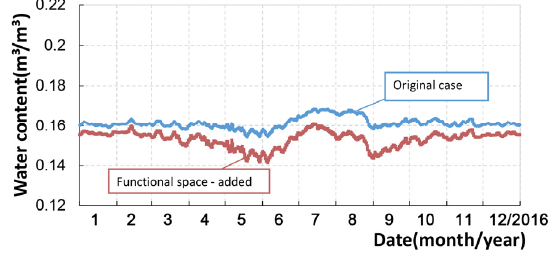
Figure 13. Point 4—temperature change.